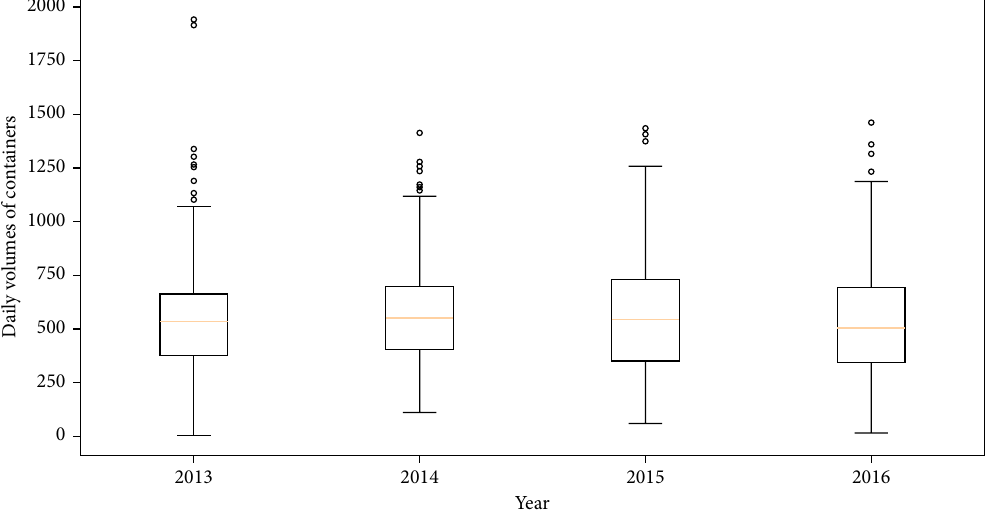
Figure 3: The box plot of daily container volumes from 2013 to